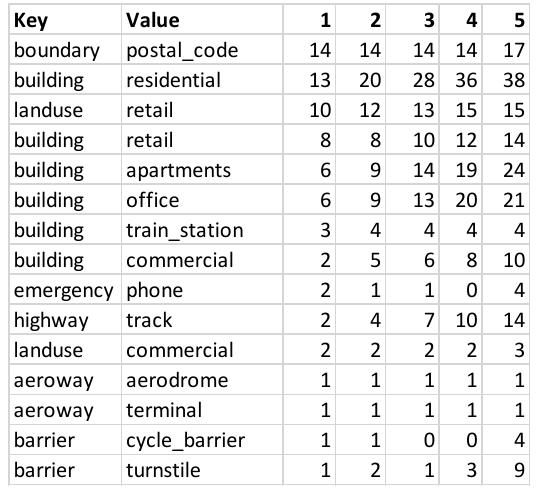
Table 4. List of objects which do not exists around current ATM but were observed before